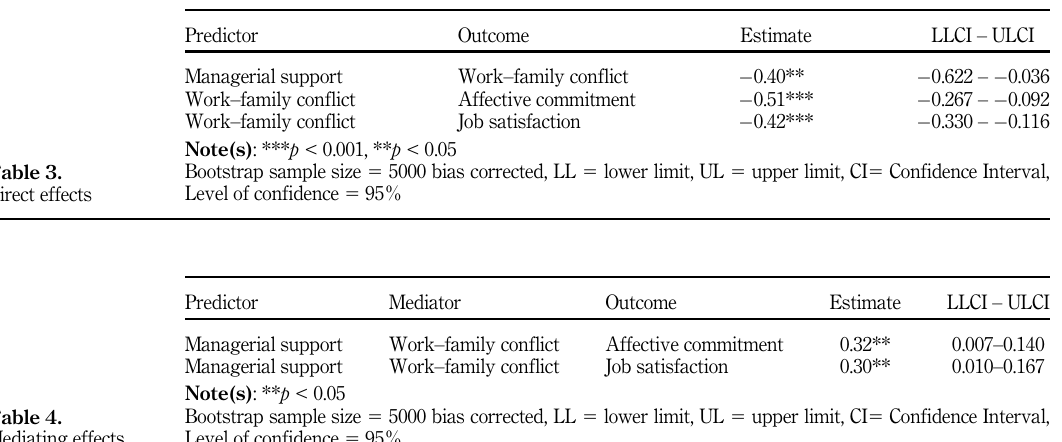
Table 4. Mediating